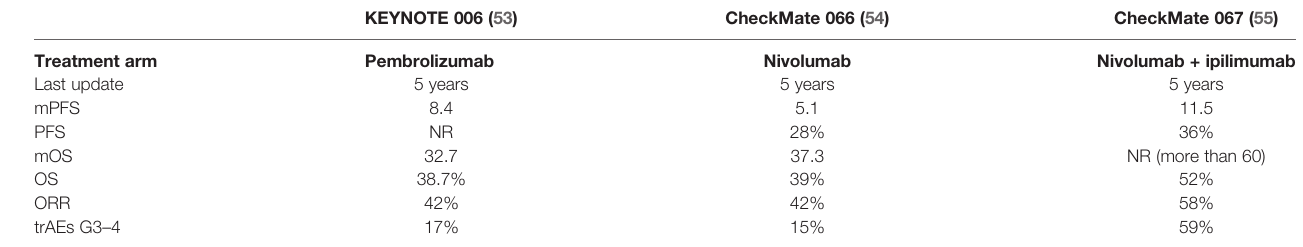
TABLE 3 | Last results of KEYNOTE 006, CheckMate 066 and CheckMate 067